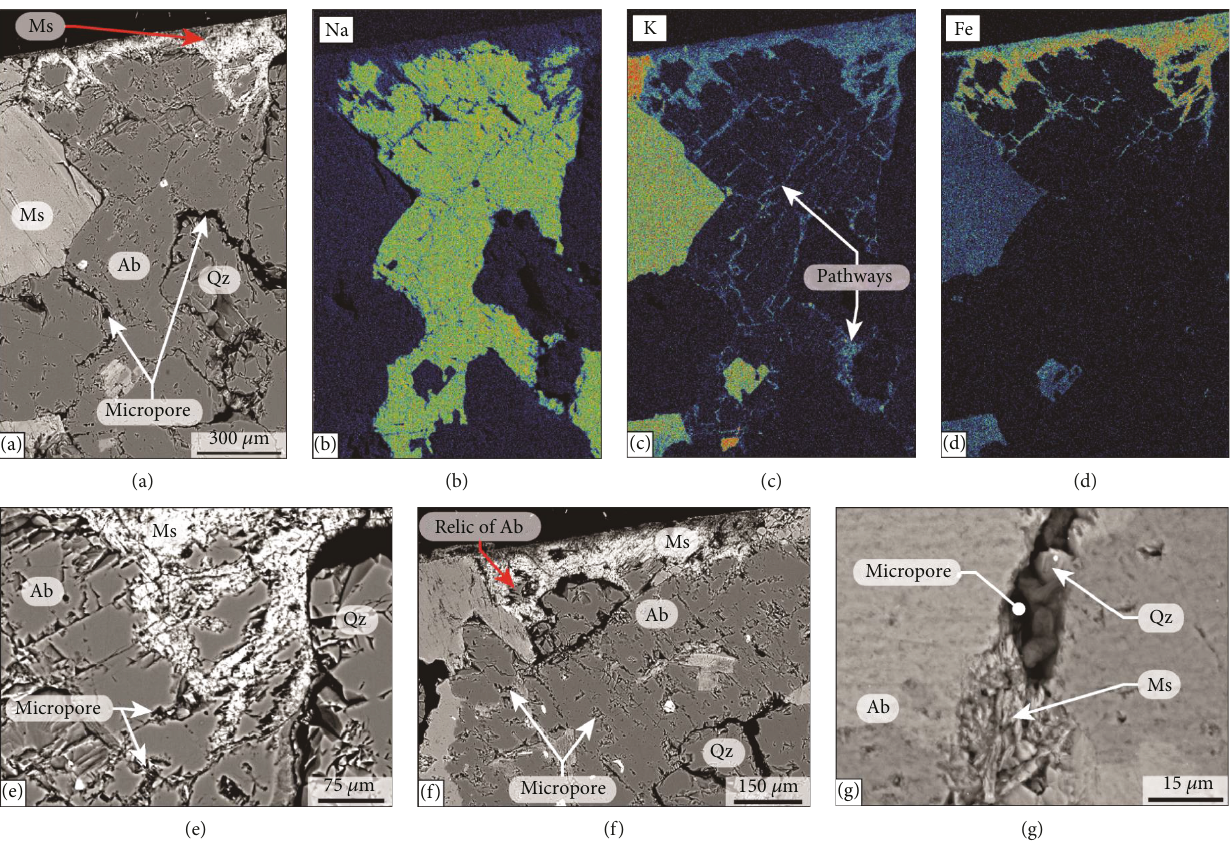
Figure 9: Texture of the alteration products obtained during the greisenization experiment. (a-d) SEM-BSE images and element maps showing the distribution of Na, K, and Fe in a partially altered part of the granite core. These maps display the pathways along which fl uids have preferentially fl owed and altered albite into muscovite during the experiment. (e) SEM photomicrograph showing the dissolution and enlargement of the pathway along the grain boundary between quartz and albite and the development of micropore along the cleavage planes of albite. (f) SEM photomicrograph showing the microporous texture of a partially altered albite. (g) Zoom on a micropore developed during the experiment that was partially coated by euhedral quartz and muscovite. Abbreviations from Whitney and Evans [45]. Ab: albite; Ms: muscovite; Qz: